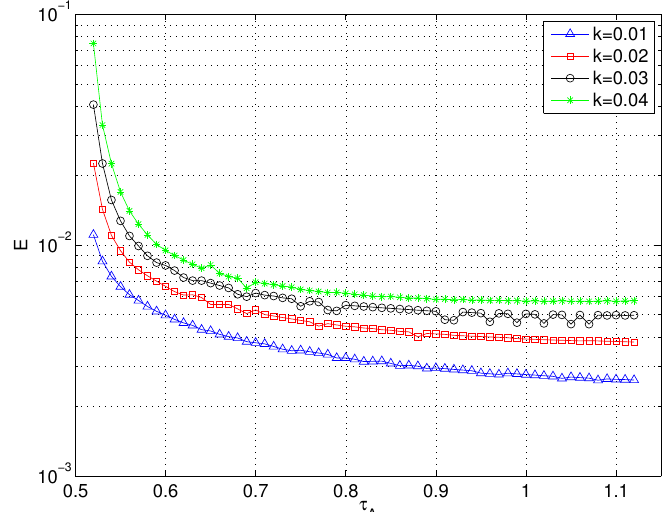
Figure 1. Numerical error of reaction diffusion simulations as a function of relaxation parameter τ A for several reaction rates k